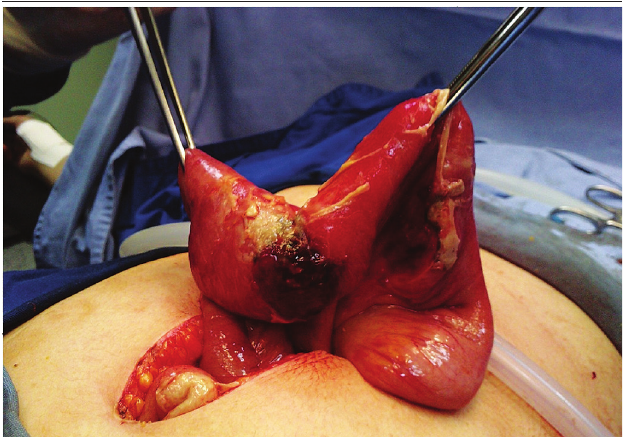
figurE 1 − Hemorrhagic lesion, with ill-defined borders and small intestine perforation